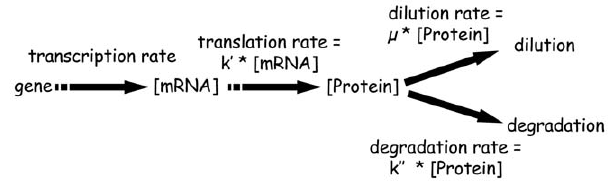
Figure 2. Modeling of the cellular process. Translation, dilution and degradation rates expressed respectively by k 9 [mRNA]), m [protein] and k 0 [protein] where k 9 is the translation efficiency, m the growth rate and k 0 the degradation rate